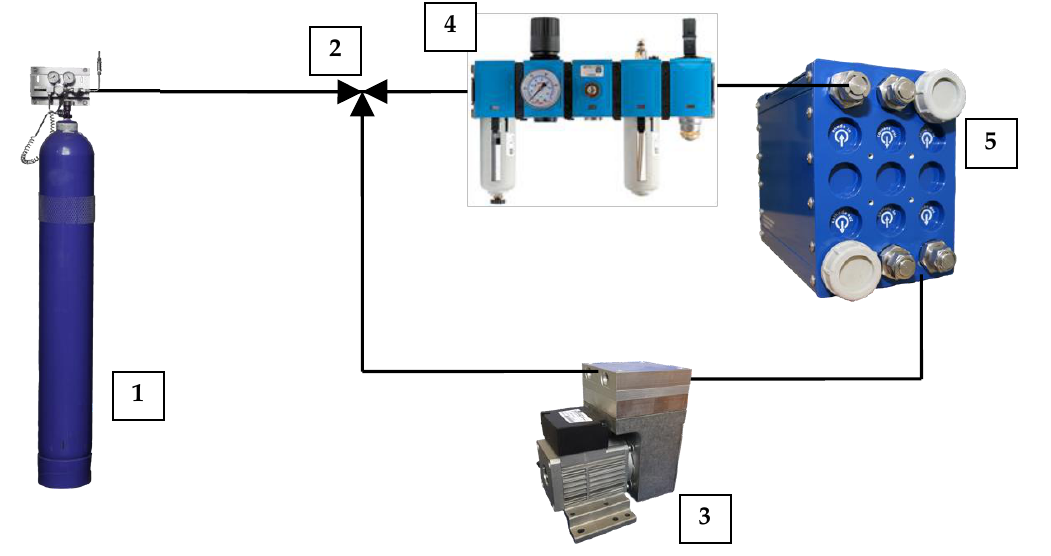
Figure 3. Structure of oxygen subsystem in typical configuration: 1, oxygen storage unit; 2, three-way valve; 3, oxygen recirculation pump; 4, oxygen preparation block; 5, PEM fuel cell stack.